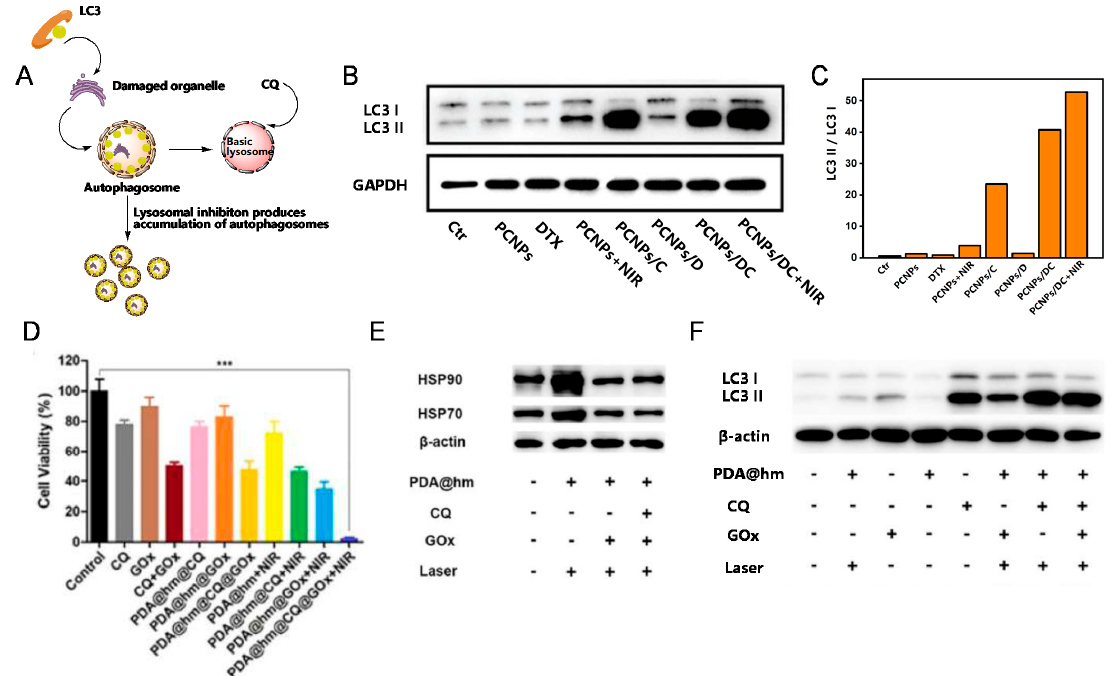
Figure 5. ( A ) The mechanisms of autophagy inhibition induced by CQ and relative LC3-mediated pathway. ( B ) Western blot analysis of LC3-I and LC3-II expression in MDA-MB-231 cells under different treatments. ( C ) Corresponding gray-scale analysis of the western blot analysis. ( D ) Augmented cell cytotoxicity by mild PTT in combination with glucose consumer GOx and autophagy inhibitor CQ in HepG-2 cells. n = 3; *** p < 0.001. ( E ) Representative expression of HSP90 and HSP70 after different treatments by western blot analysis. ( F ) Relative LC3-I and LC3-II expression in HepG-2 cells after different treatments. β -actin was used as an internal